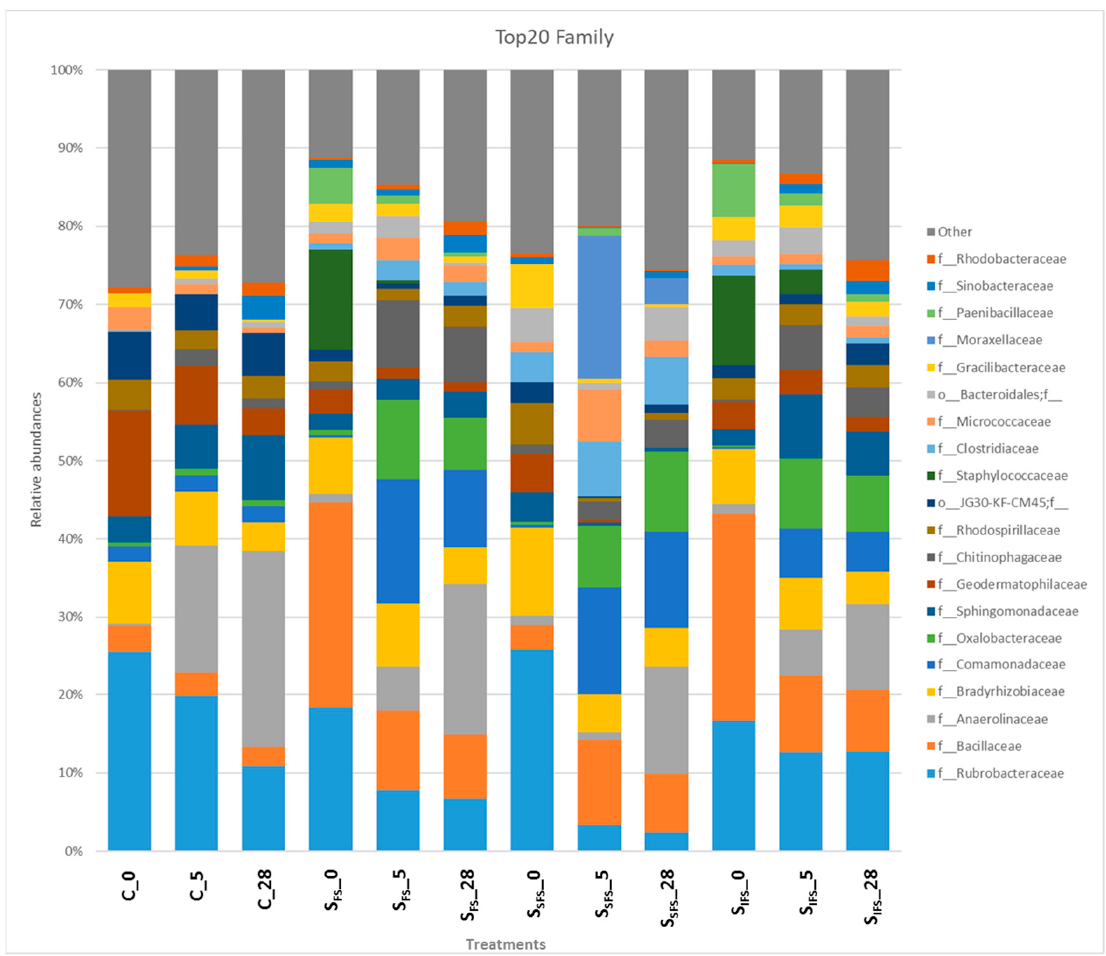
Figure 6. The top 20 most-abundant identified bacterial families. The remaining 120 families were collected into “Other”. Figure shows the data of treatments with 0.5% w / w of the different sludge derived products. C_0: control soil at day 0; C_5: control soil at day 5; C_28: control soil at day 28; SFS_0: soil treated with the soluble total fermented sludge at day 0; SFS_5: soil treated with the total fermented sludge at day 5; SFS_28: soil treated with the total fermented sludge at day 28; SSFS_0: soil treated with the soluble fraction of fermented sludge at day 0; SSFS_5: soil treated with the soluble fraction of fermented sludge at day 5; SSFS_28: soil treated with the soluble fraction of fermented sludge at day 28; SIFS_0: soil treated with the insoluble fraction of fermented sludge at day 0; SIFS_5: soil treated with the insoluble fraction of fermented sludge at day 5; SIFS_28: soil treated with the insoluble fraction of fermented sludge at day